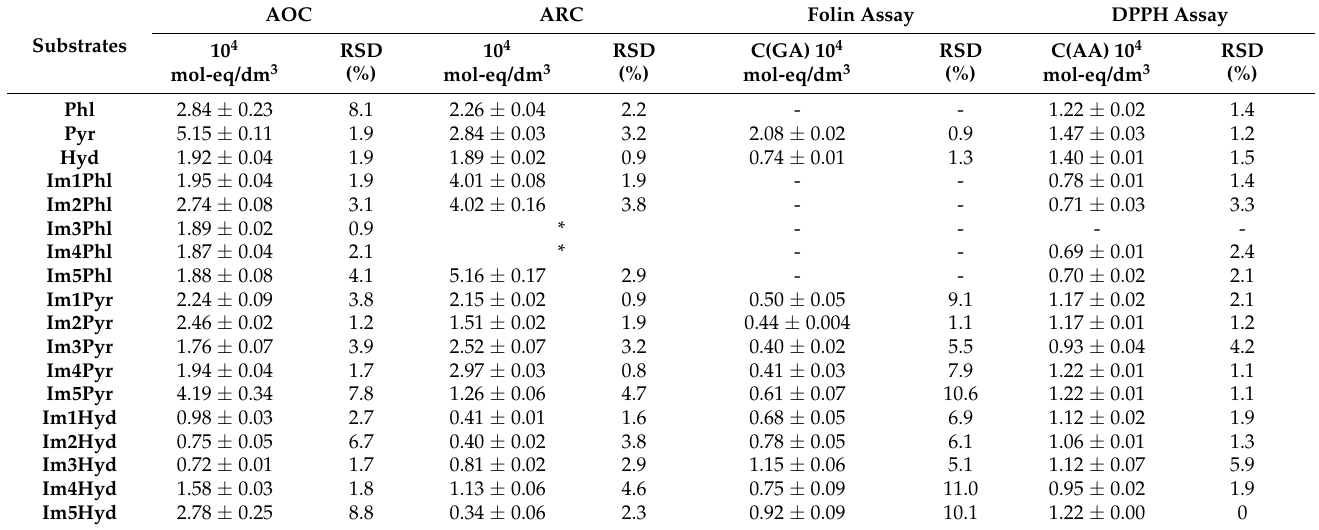
Table 3. Antioxidant properties of phenols and imidazolylpolyphenols (10 4 mol-eq/dm 3 , 25 ◦ C, n = 5, p = 0.95).